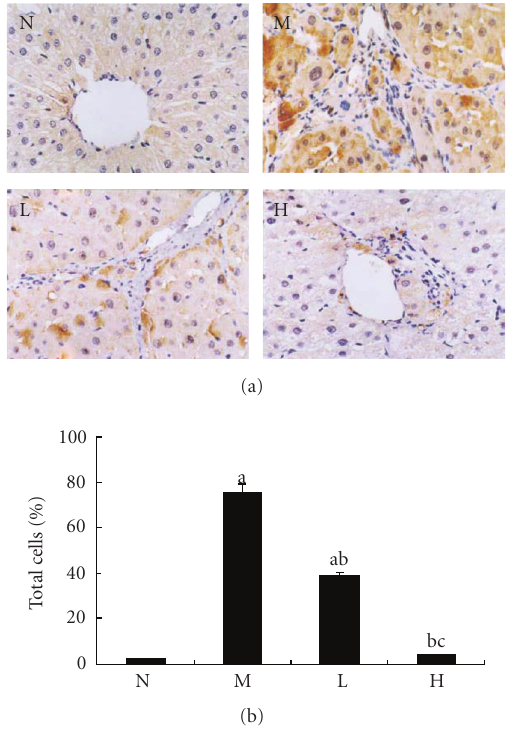
Figure 7: Immunohistochemical staining for E-selectin in rat liver. N represented the normal control group; M represented the model group; L represented the group treated with low dose of thalido- mide; H represented the group treated with high dose of thalido- mide. (a) Positive E-selectin cells were mainly distributed at the fibrosepta band, area of necrosis, and inflammatory cell infiltra- tion in hepatic lobules (M, L, and H) (original magnification N, M, L, H, × 400, immunohistochemical staining). (b) Comparison of the expression of E-selectin using immunohistochemical analy- sis. a P < . 01 versus normal control group; b P < . 01 versus model group; c P < . 01 group treated with high dose of thalidomide versus group treated with low dose of thalidomide.